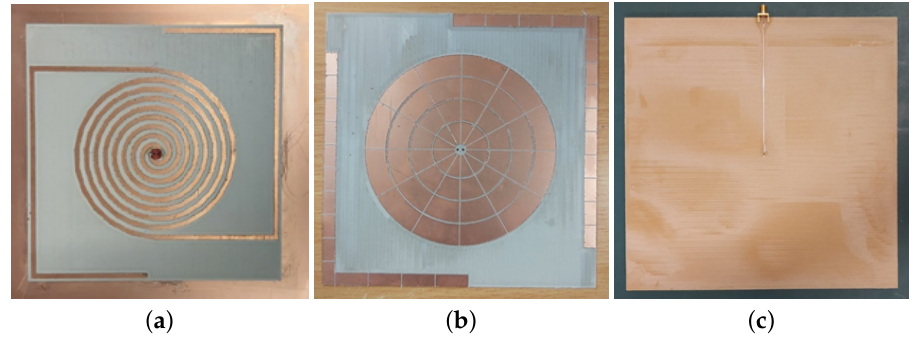
Figure 10. Fabricated prototype ( a ) Hybrid antenna layer ( b ) HIS layer ( c ) Ground back FR-4 layer with feed